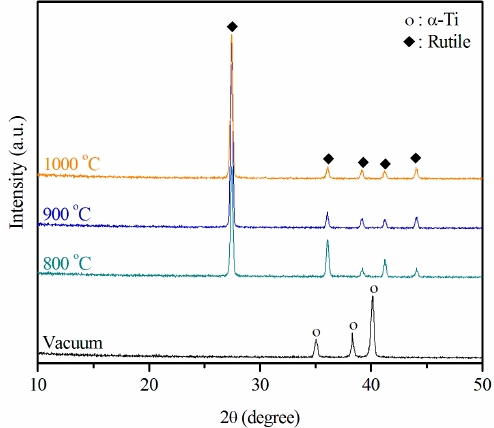
Figure 1. X-ray diffraction (XRD) patterns of Ti foams sintered at 800, 900, and 1000 °C in air and of a foam sintered at 1100 °C in vacuum.